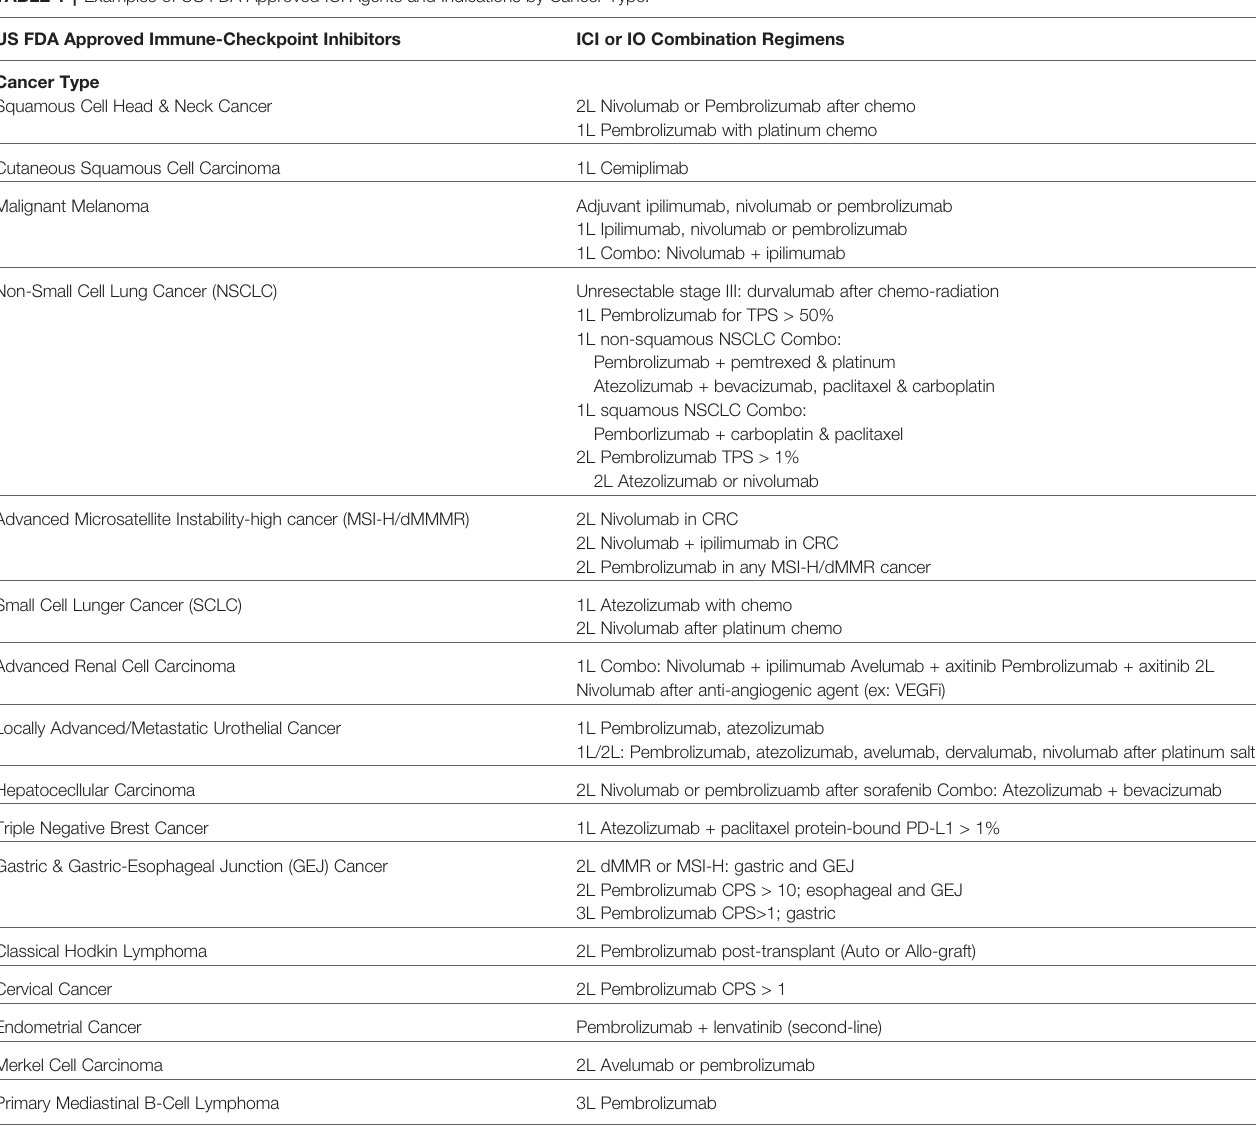
TABLE 1 | Examples of US FDA Approved ICI Agents and Indications by Cancer Type. US FDA Approved Immune-Checkpoint Inhibitors ICI or IO Combination Regimens Cancer Type Squamous Cell Head & Neck